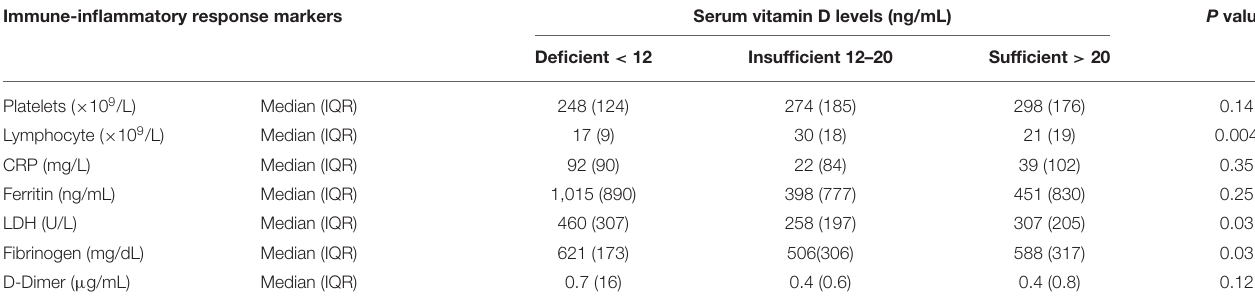
TABLE 6 | Comparative analysis of the association between serum 25(OH)D levels and immune -inflammatory response